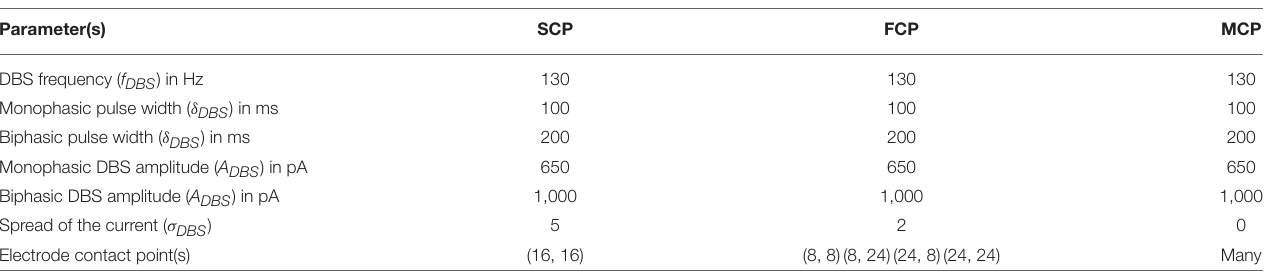
Frontiers in Neural Circuits |